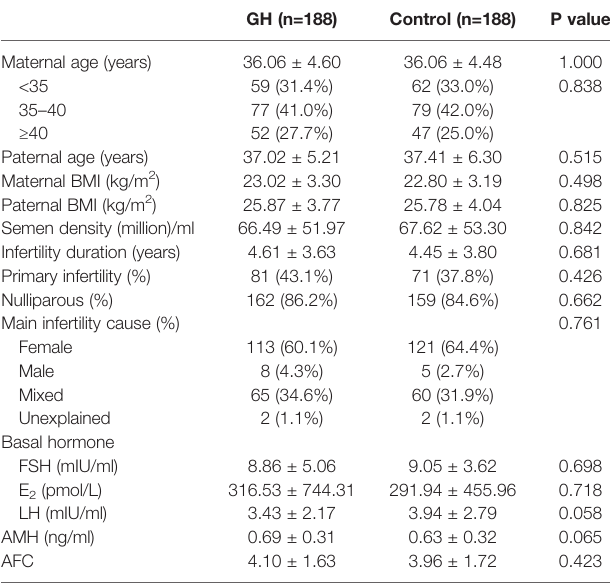
TABLE 1 | Characteristics of patients.